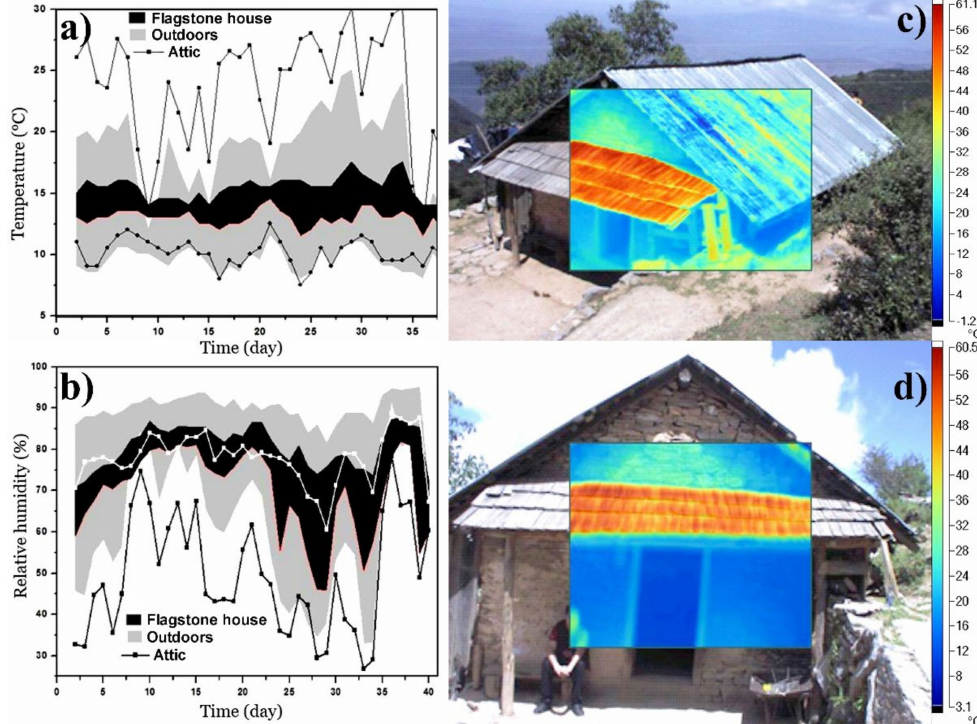
Figure 5. ( a ) Temperature and ( b ) relative humidity of the flagstone construction and outdoor environment. Lines show the values of the attic, locally named “ tapanco” . Thermographic images of the flagstone construction in the Sierra Gorda of Quer é taro, M é xico. ( c ) Frontal view and ( d ) “ tejamanil” shed over the